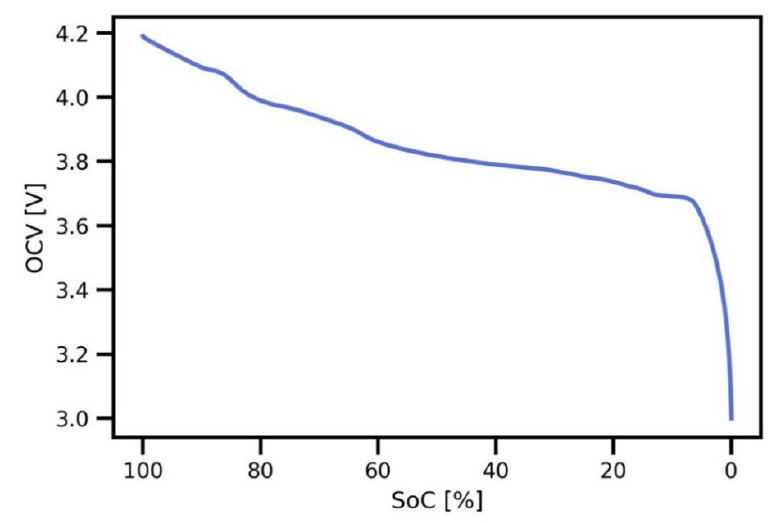
Figure 3. The relationship of the open circuit voltage with the state-of-charge. The OCV of a Lithium cobalt oxide (LCO) battery produced by Melasta Battery (Model No. SLPBB042126HN) with a capacity of 6550 mAh. The battery was cycled in an Arbin Instruments cycler at 25 °C. The OCV was estimated from cycling at a c-rate of c/20, and the SoC was estimated using the coulomb counting method.